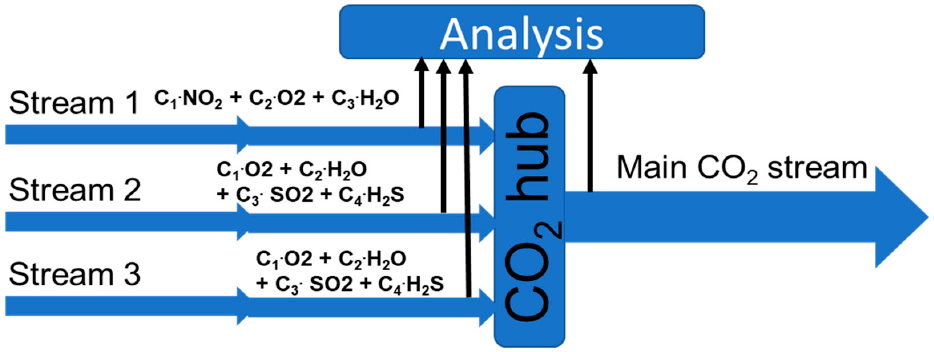
Figure 11. The mixing of different CO 2 streams with known impurities and concentration in a hub.